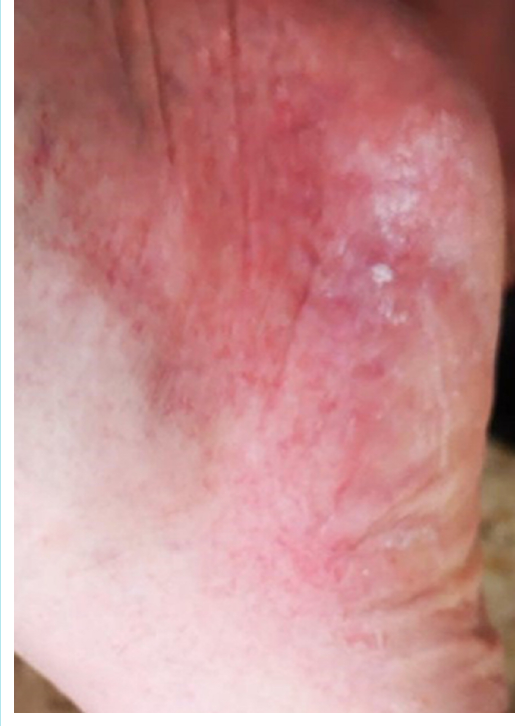
Figure 4: Contact dermatitis of the foot – delayed-type hypersensi- tivity few days after treatment with prednisolone acetate